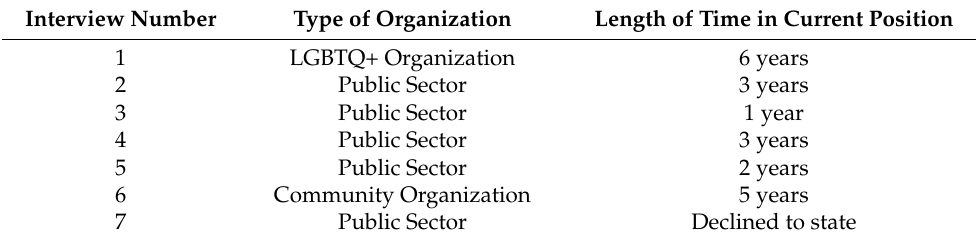
Table 1. Key characteristics of the interview